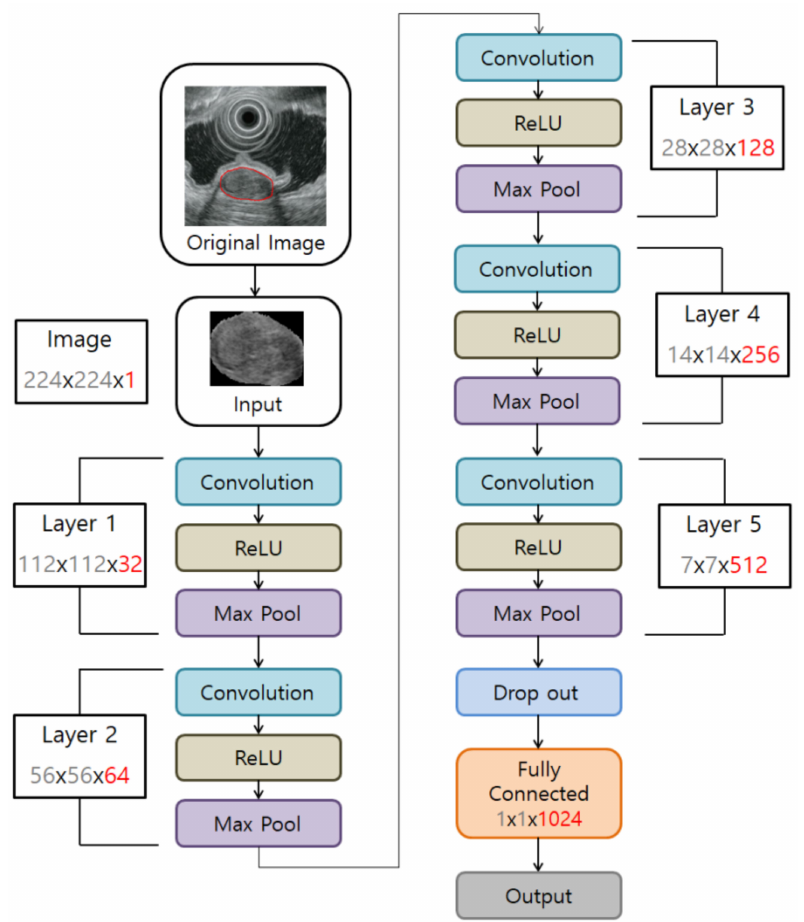
Figure 1. Convolutional neural network computer-aided detection system